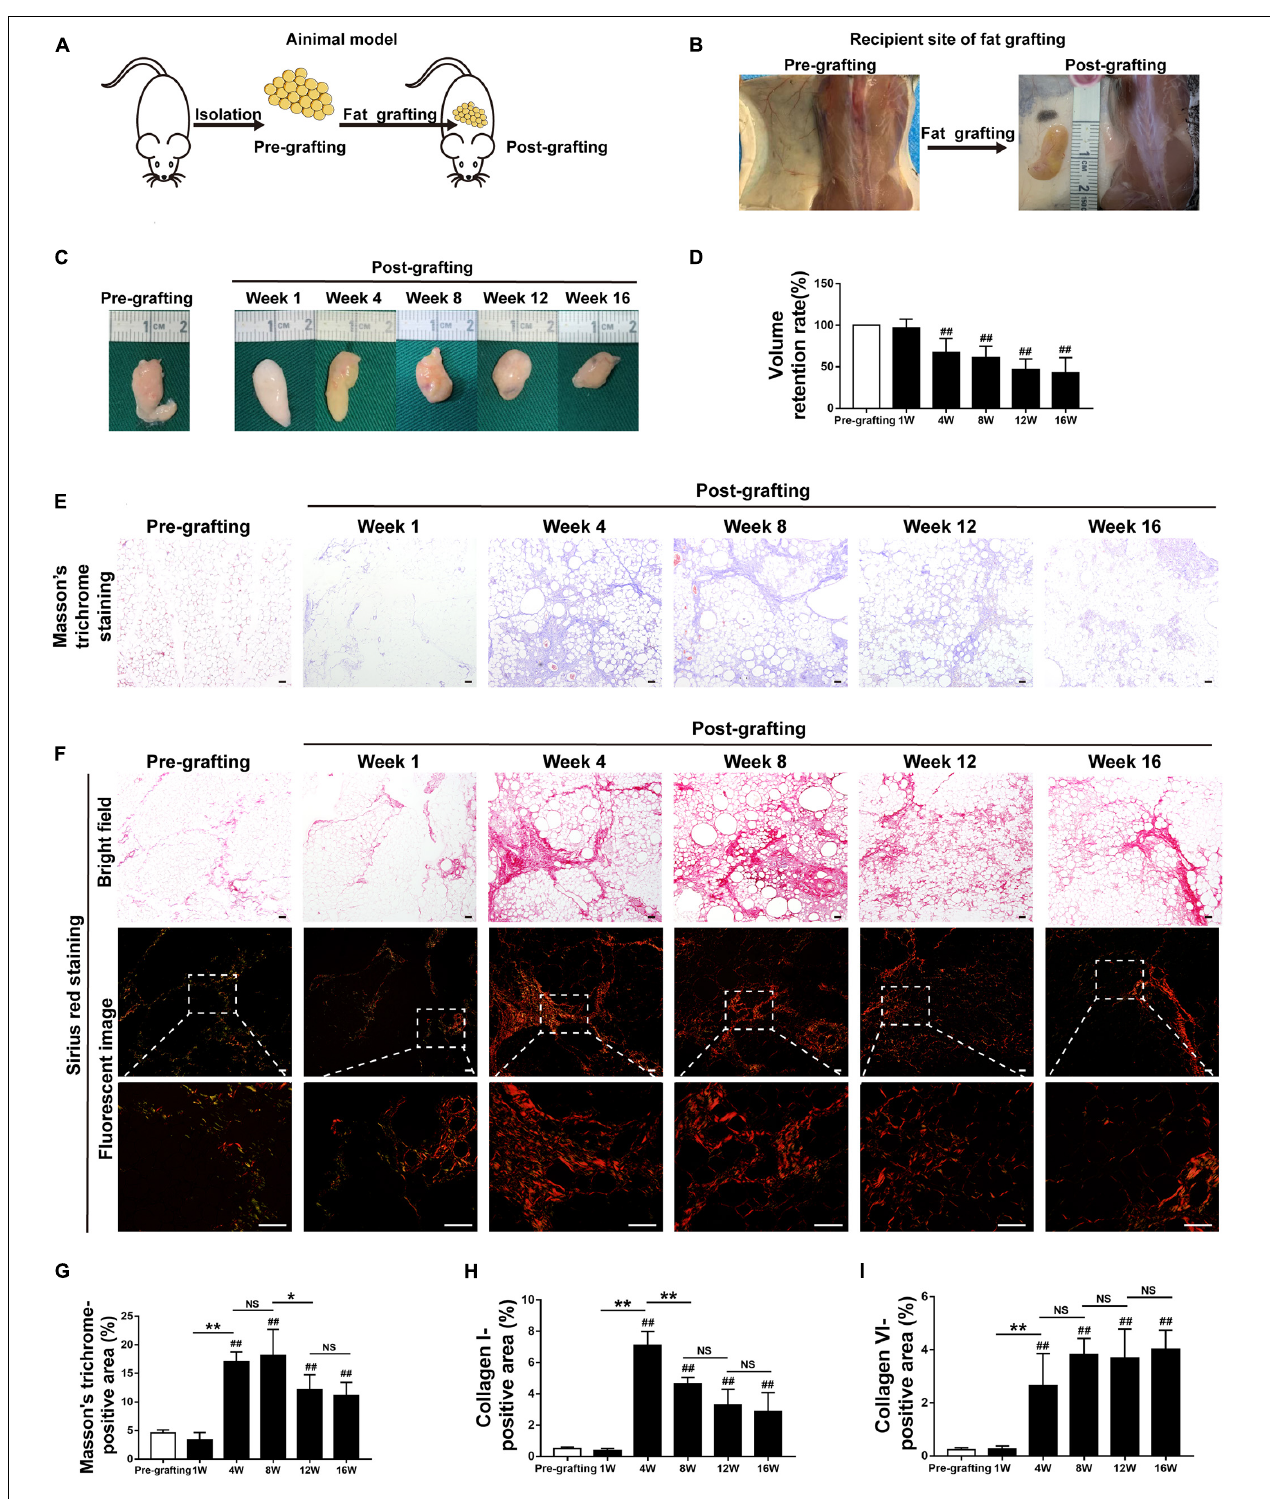
FIGURE 1 | Adipose tissue fibrosis is increased in fat graft tissue. (A,B) Illustration of the animal model. (C) Macroscopic views of harvested fat tissue. (D) The retention volume of the fat grafts over time. (E) Representative Masson’s trichrome staining of fat tissue before and after grafting. (F) Representative Sirius red staining of fat tissue before and after grafting. (G–I) Quantification of the areas positive for Masson’s trichrome (G) , collagen I (H) , and collagen VI (I) staining in fat tissue before and after grafting. Scale bars = 50 µ m. Data are presented as the mean ± SD. ## P < 0.01 compared with the pre-grafting group; * P < 0.05, ** P < 0.01.